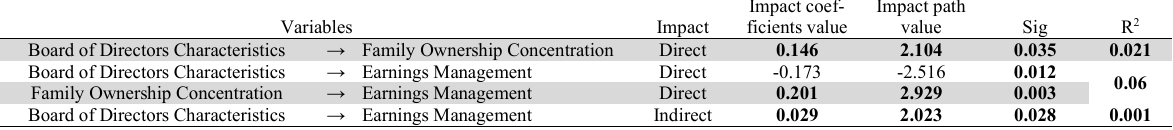
The results of the path analysis test using structural equations modeling